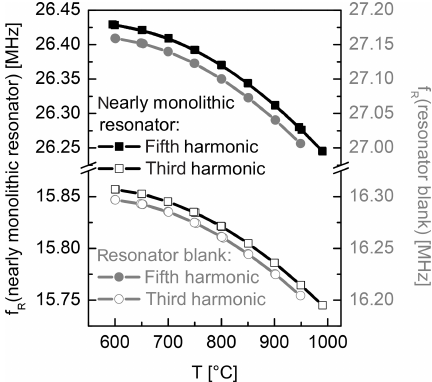
Figure 10. Temperature dependence of the resonance frequency of the third and the fifth harmonics for the nearly monolithic resonator (black curves, left axis) and the resonator blank (grey curves, right